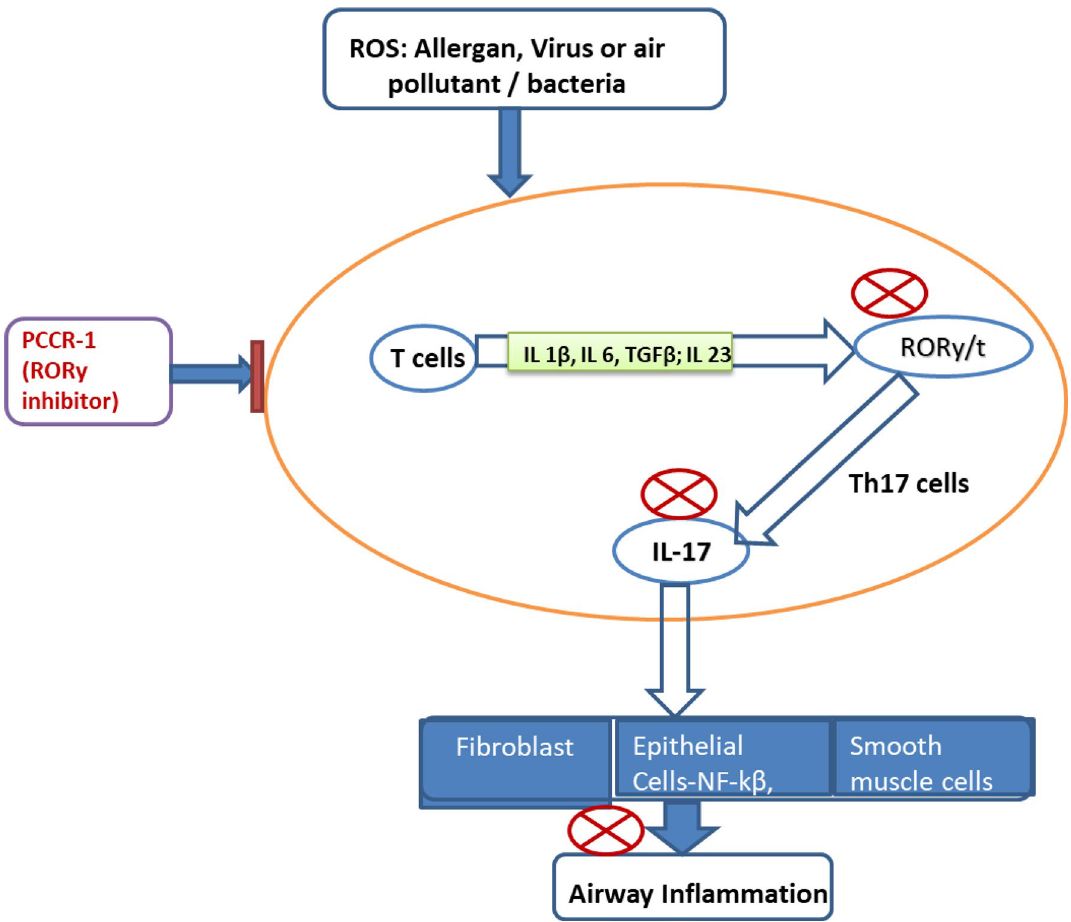
Figure 5. Inhibitory mechanism of PCCR-1 in RORγ and IL-17 dependent pathway. RORγ as an anti- inflammatory therapeutic target for COPD in regulating the Th17 dependent signaling. Small molecule inhibitors of RORγ leads to blockage of IL-17 release leading to prevention of various inflammatory mediators from airway epithelial cells and airway smooth muscle cells thus preventing further damage to the